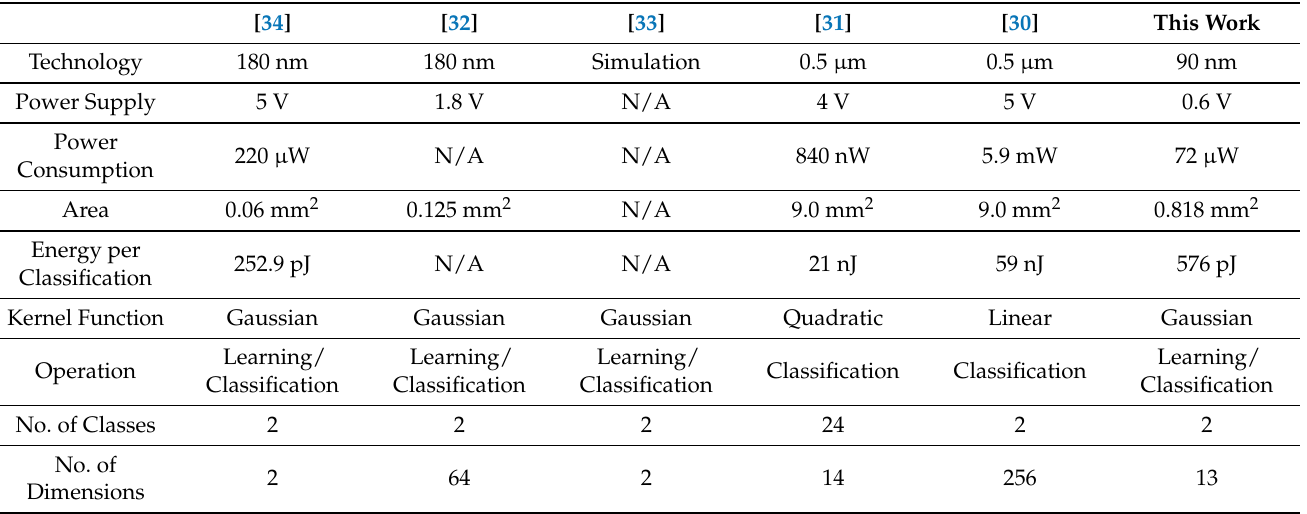
Table 7. Performance